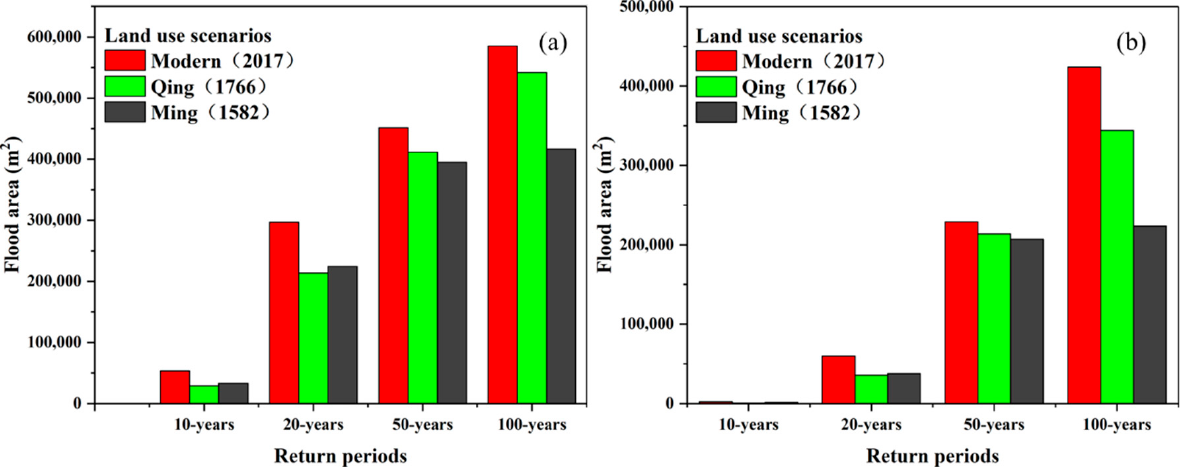
Figure 9. ( a ) level II and ( b ) level III inundation area. Table 7. Inundation area at level II and level